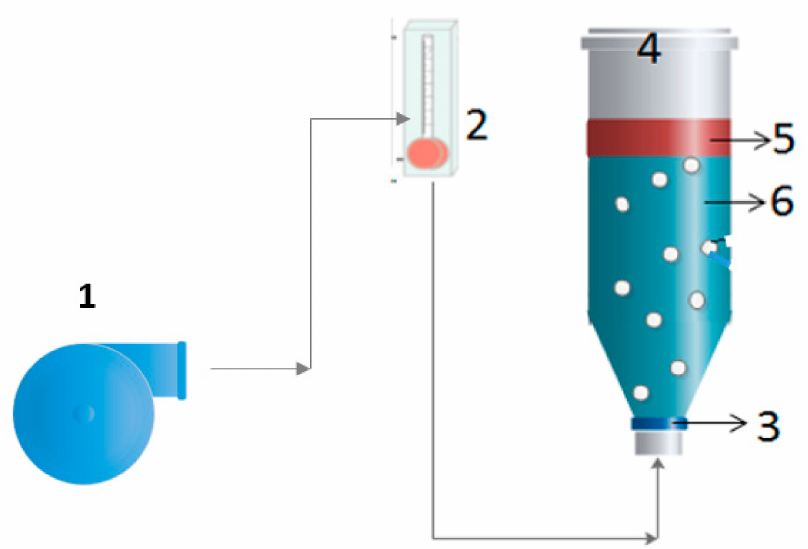
Figure 1. Schematic diagram illustrating the apparatus set-up of liquid biphasic flotation (LBF) system for protein extraction. 1: Air pump; 2: flowmeter; 3: sintered disk; 4: LBF column; 5: top alcohol phase; 6: bottom salt